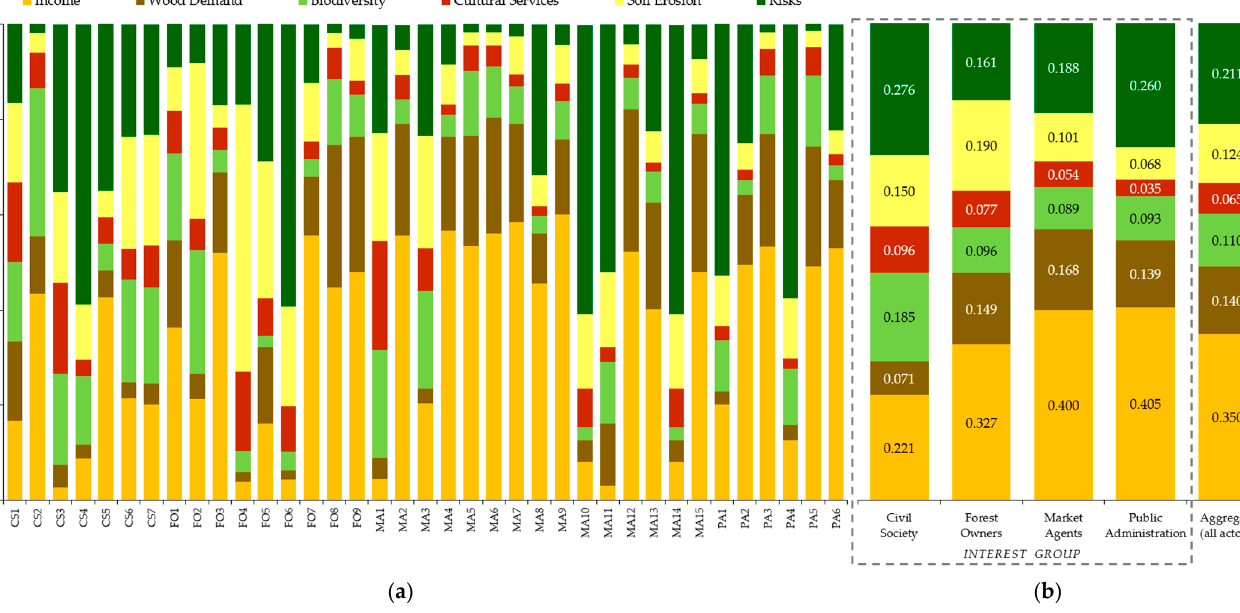
Figure 8. Weights of criteria: ( a ) Weights assigned by each actor (CS—civil society; FO—forest owners; MA—market agents; PA—public administration); ( b ) Aggregated weights by interest group and aggregated all actors. Criteria weights for each interest group were calculated with the consensus convergence algorithm which is presented in the Code A1 and the aggregate weights of all actors’ criteria were calculated with Equation (1).